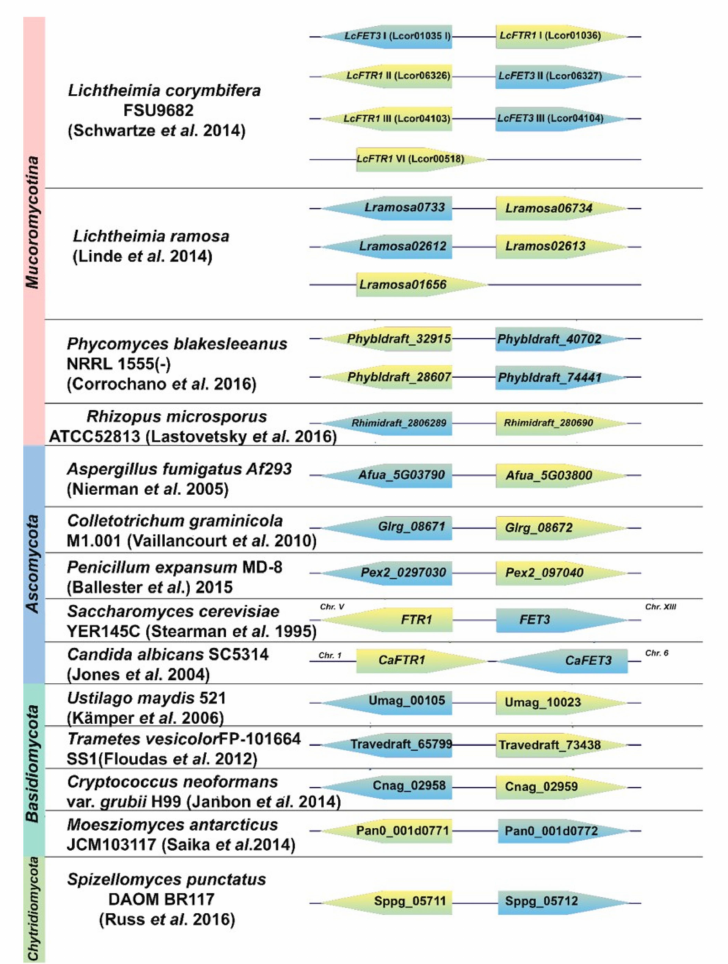
Figure 2. Synteny of Ftr1 (green) and Fet3 (blue) orthologue genes in different fungal division; all genes included were annotated as FTR1/FET3 or found to closely match known genes in BLAST analysis; labels represent the locus tag in the annotated genome; arrows indicate coding orien- tation; arrow length not representative of protein sizes, all data were obtained from the NCBI database